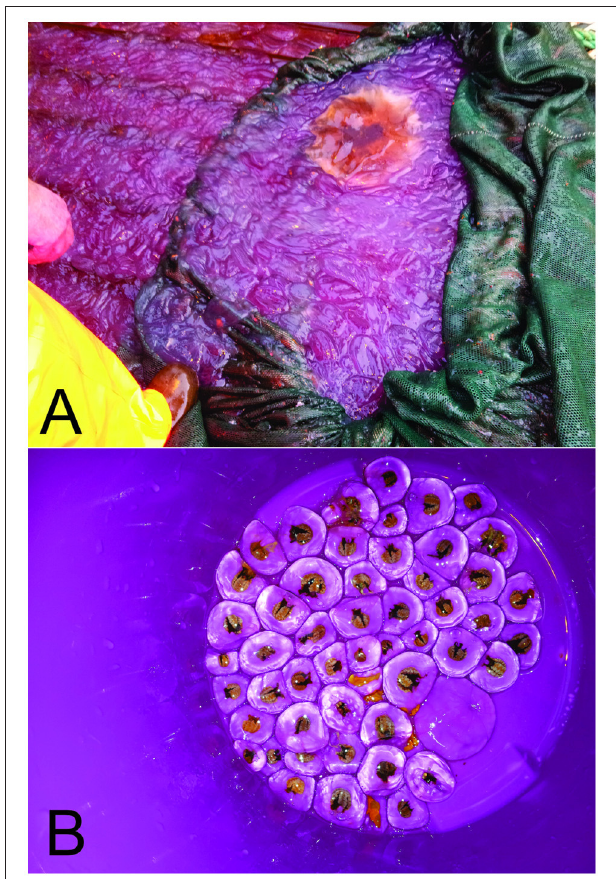
FIGURE 6 | (A) Picture showing the dominant species, the ctenophore Beroe cucumis caught by pelagic trawl st1688 on 6 November 2015. Note the boot in the lower left part of the picture as a “size reference.” (B) Exemplary specimens of the hydrozoan Modeeria rotunda in the bottom of a plastic bucket ( ∼ 15cm diameter) caught in the pelagic trawl st1688 on 6 November 2015.